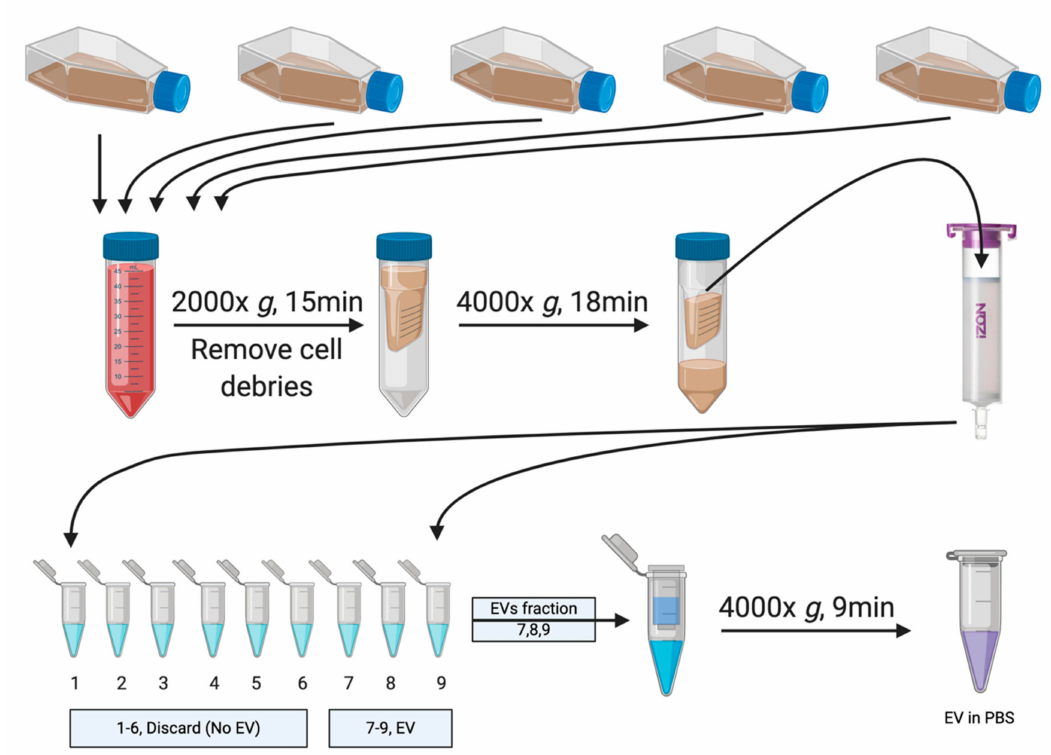
Figure 1. Schematic workflow of extracellular vesicle (EV) isolation. EVs were isolated from the serum-free media of inner medullary collecting duct (mIMCD) and T2J Cell lines ( Tsc2 deleted mIMCD cell lines). Pooled media were subjected to a low speed spin to remove the cells and cell debris. The cleared media were then transferred to a EV concentration device to bring the volume to 500 µ L. This was then loaded onto the qEV size exclusion chromatography column. Elution was performed by gravity with fractions of 500 µ L of sterile phosphate bu ff ered saline (PBS) and the EV-rich fractions (seventh–ninth) were pooled and concentrated again using the concentrating device and used for downstream